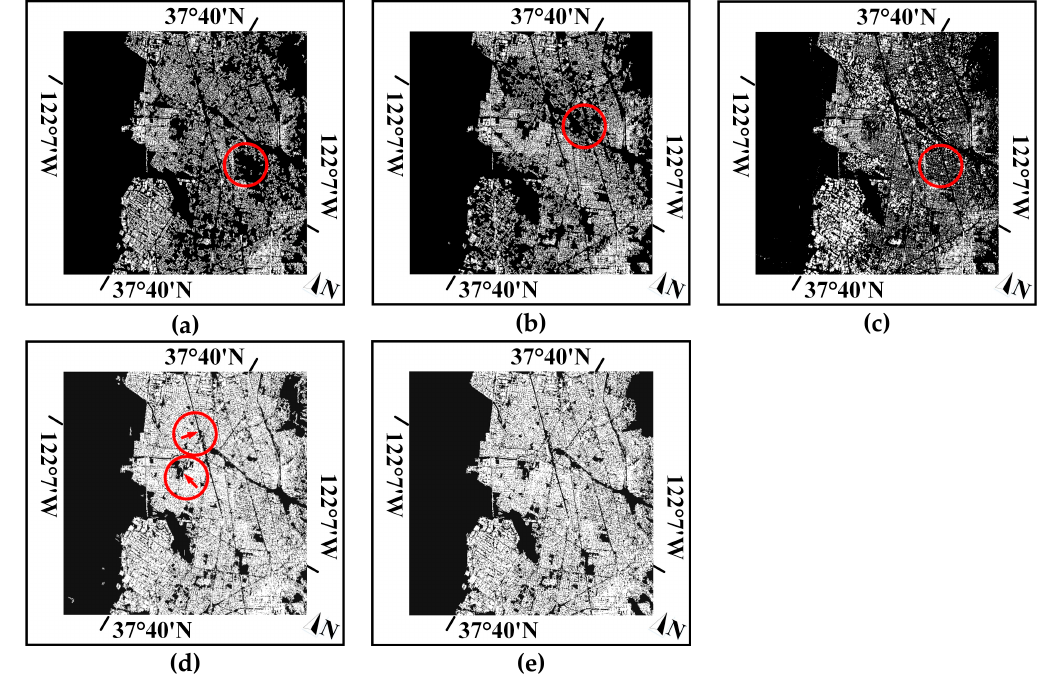
Figure 7. Comparison of different building extraction methods for UAVSAR data. ( a ) Azmedroub’s method, ( b ) Xiang’s method, ( c ) Quan’s method, ( d ) the proposed method, ( e ) ground truth.